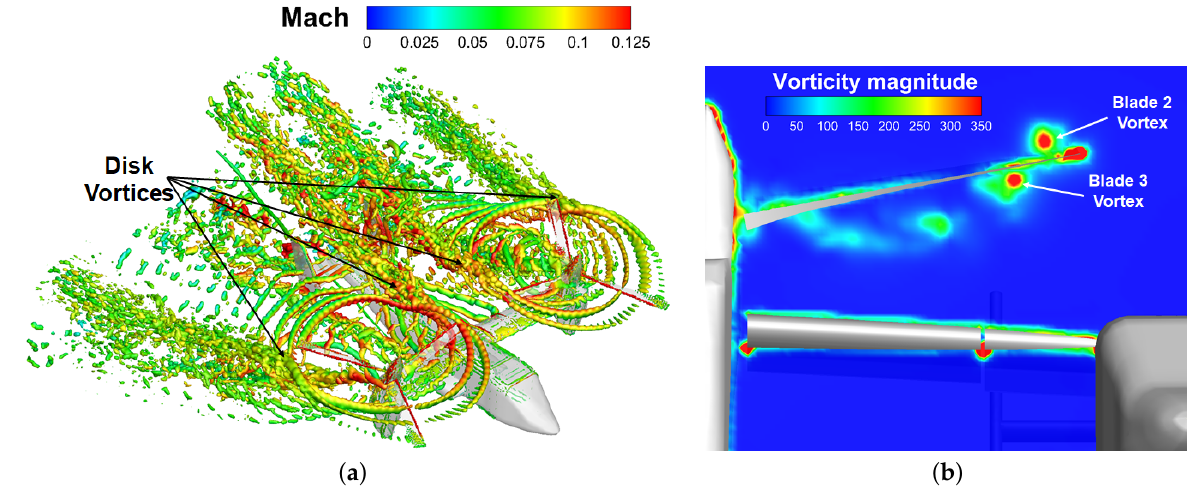
Figure 16. Instantaneous flow field computed by DUST in conversion flight condition at ψ = 270 ◦ , θ N = 75 ◦ , V ∞ = 40 kts, Ω = 589 RPM: ( a ) iso-surface of Q-Criterion, ( b ) iso-contours of vorticity on a slice cutting the nacelle